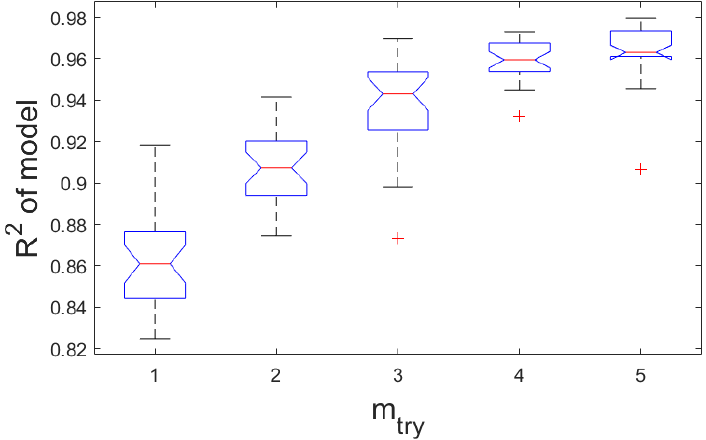
Figure 6. E ff ect of the random forest hyperparameter m try on the model performance in Case 2 based Figure 6. Effect of the random forest hyperparameter 𝑚 (cid:3047)(cid:3045)(cid:3052) on the model performance in Case 2 based on 30 on 30 runs. Figure 6. Effect of the random forest hyperparameter 𝑚 (cid:3047)(cid:3045)(cid:3052) on the model performance in Case 2 based on 30 runs.